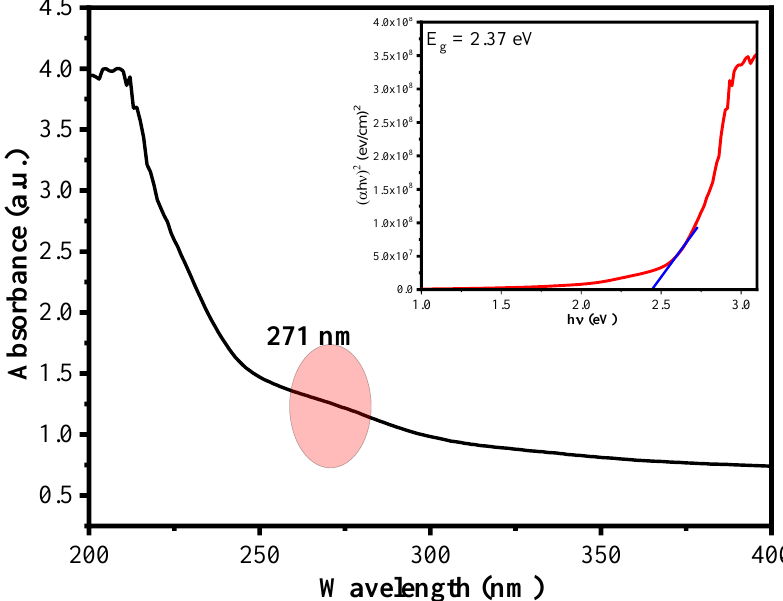
Figure 6. UV–Vis plot of CuO/Alg-Agar BNC having wavelength range (200–400 nm) and inset showing Tauc’s plot for calculating the energy band gap value for the material. The oxidation state and chemical composition of each element in the synthesized ma- terial were evaluated by using X-ray photoelectron spectroscopy (XPS) analysis [46]. Fig- ure 7a shows a survey scan of the CuO/Alg-Agar BNC, suggesting that Cu, C and O are main elements of the synthesized material. Figure 7b shows the O1s spectrum at binding energy 530.5 eV which corresponds to the surface oxidation. Figure 7c shows the C1s spec- trum at binding energy 283.5 eV which corresponds to the C-C functional peak [47]. Figure 7d shows the Cu spectrum with binding energy peaks at 943 eV, 937.5 eV and 930.7 eV. These correspond to Cu 2p3/2, confirming the existence of CuO with +2 oxidation state [48].